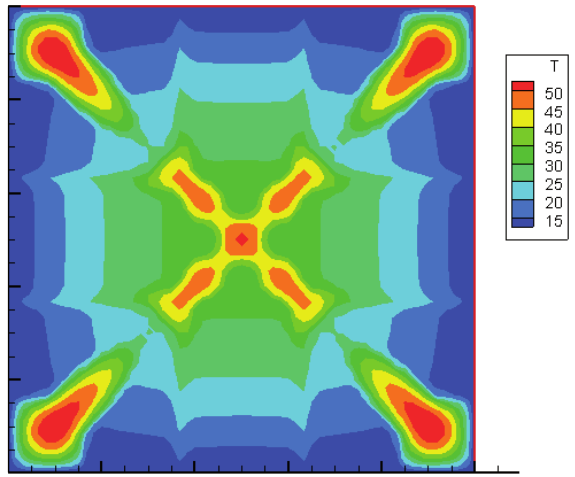
Fig. 3. Optimal distribution of high conductive material based on BESO method.